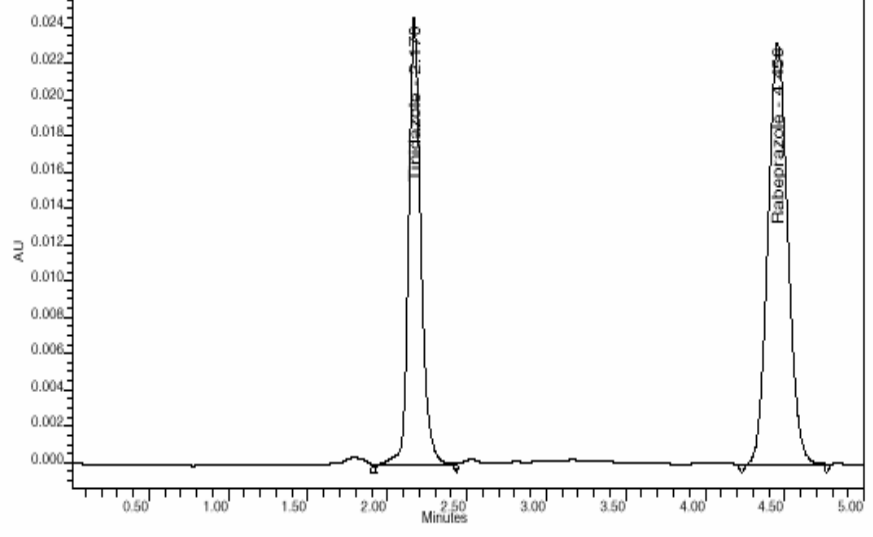
Figure 1. Typical chromatogram of rabeprazole